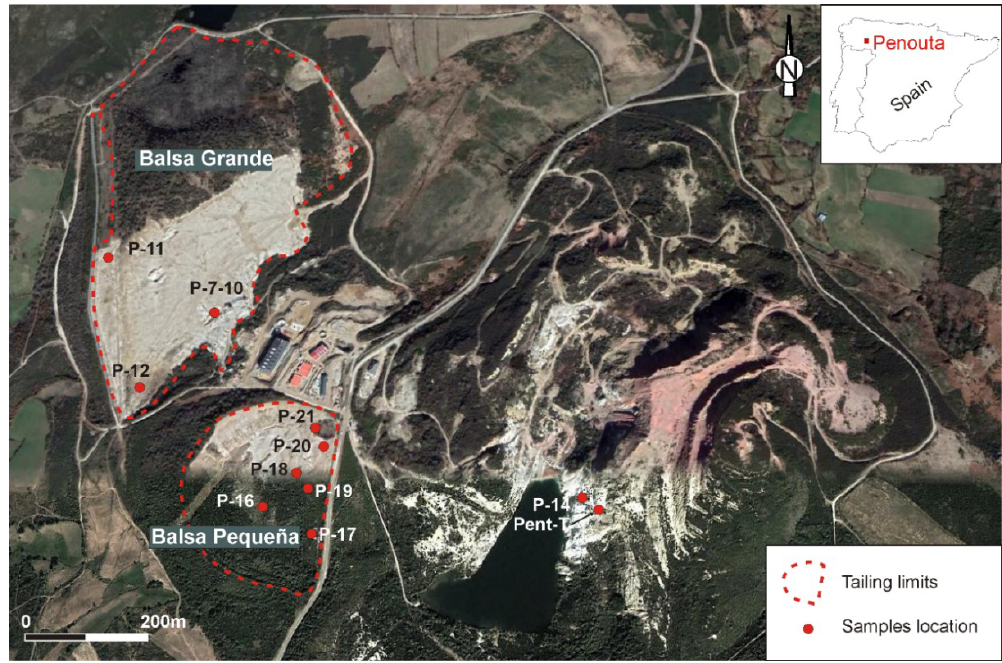
Figure 2. Satellite image with the location of the Penouta tailings.